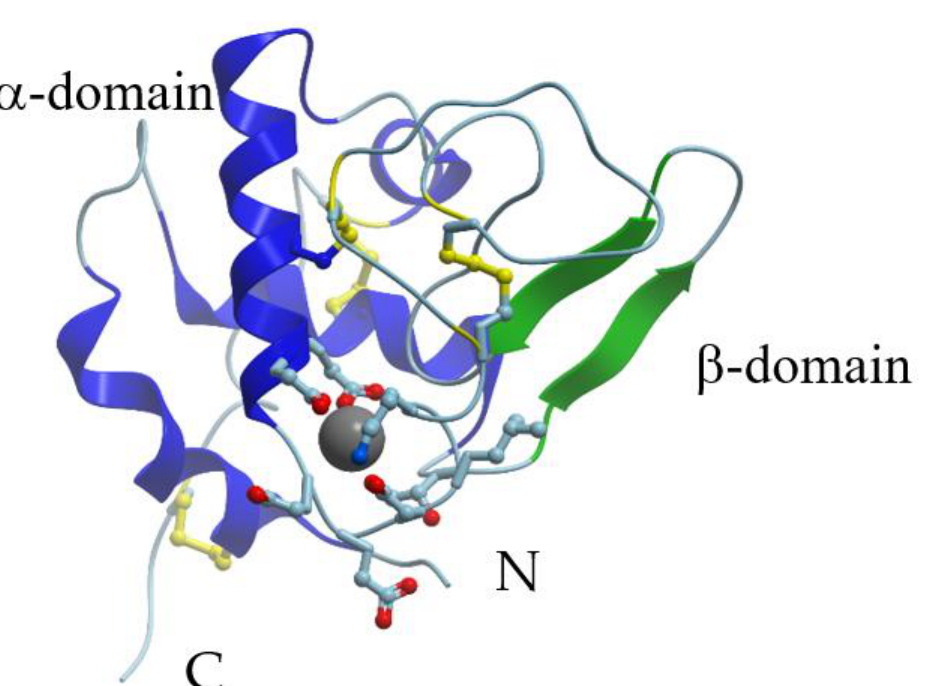
Figure 1. X-ray structure of Ca 2 + -bound human α -lactalbumin (PDB ID 1a4v). α -Helices are shown in blue; β -structure is shown in green; S-S bridges are shown in yellow. Gray sphere represents bound calcium ion, and amino acid residues taking part in its coordination are represented by stick model.